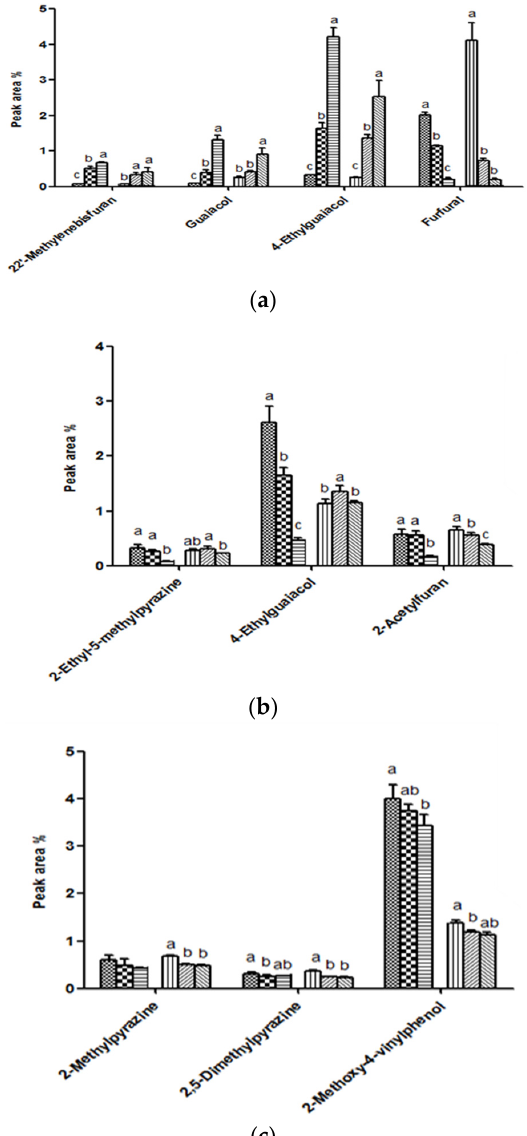
Figure 1. Levels of volatile compounds in coffee according to ( a ) roasting time and temperature (E-